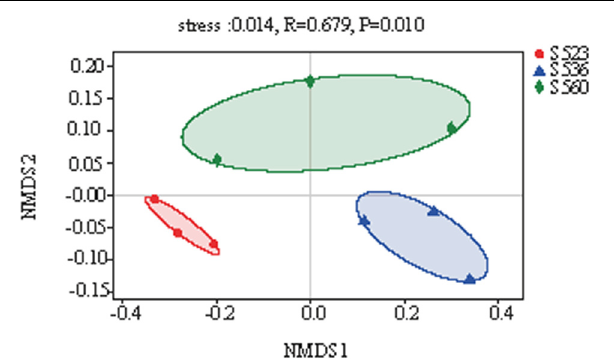
FIGURE 3 | Non-metric multidimensional scaling (NMDS) of litter samples over different phytoremediation years based on the relative abundance of bacterial operational taxonomic units